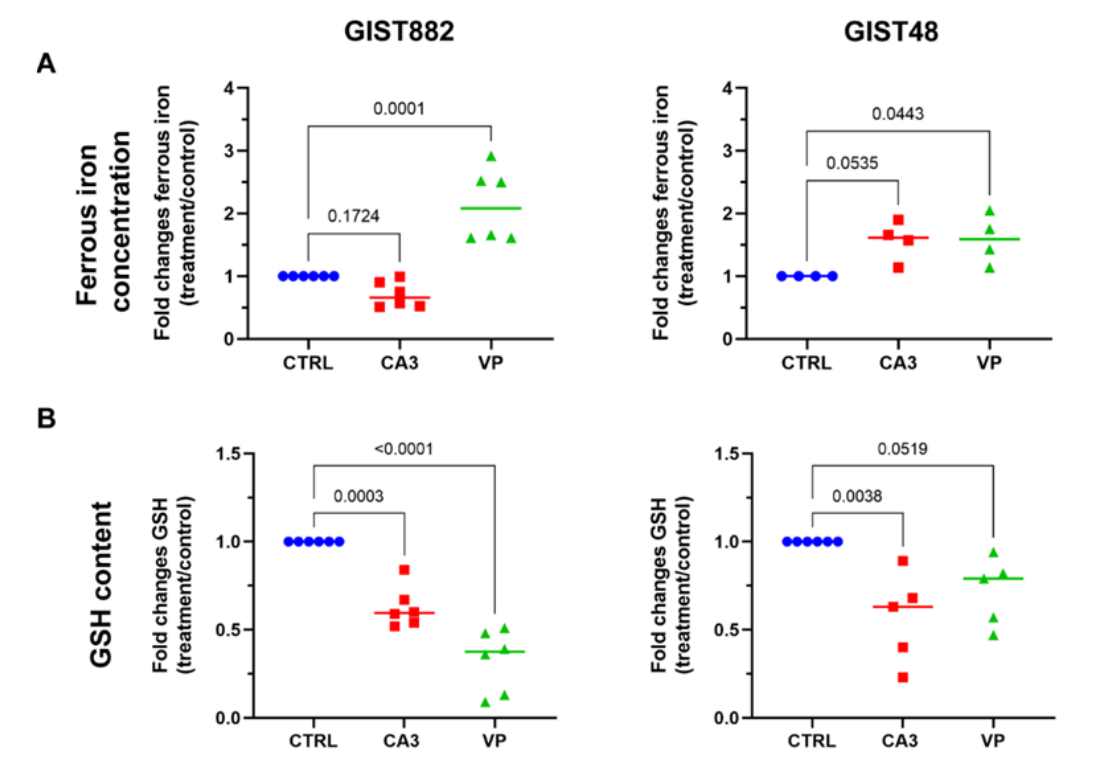
Figure 6. The effects of CA3 and VP on ferrous iron concentration and GSH content in GIST882 and GIST48 cells. GIST882 and GIST48 are shown in the left and right panels, respectively. ( A ) Ferrous iron concentration was determined in CA3- and VP-treated GIST882 and GIST48 cells. ( B ) GSH content was measured in CA3- and VP-treated GIST882 and GIST48 cells. Mean values ± SD are shown from four or six independent experiments. Statistical analysis was performed using one-way ANOVA, followed by Tukey’s test.